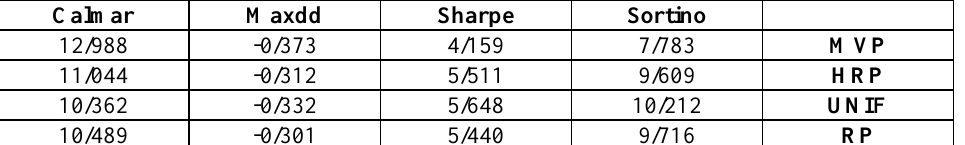
Table 5. Evaluation of out-of-sample optimization